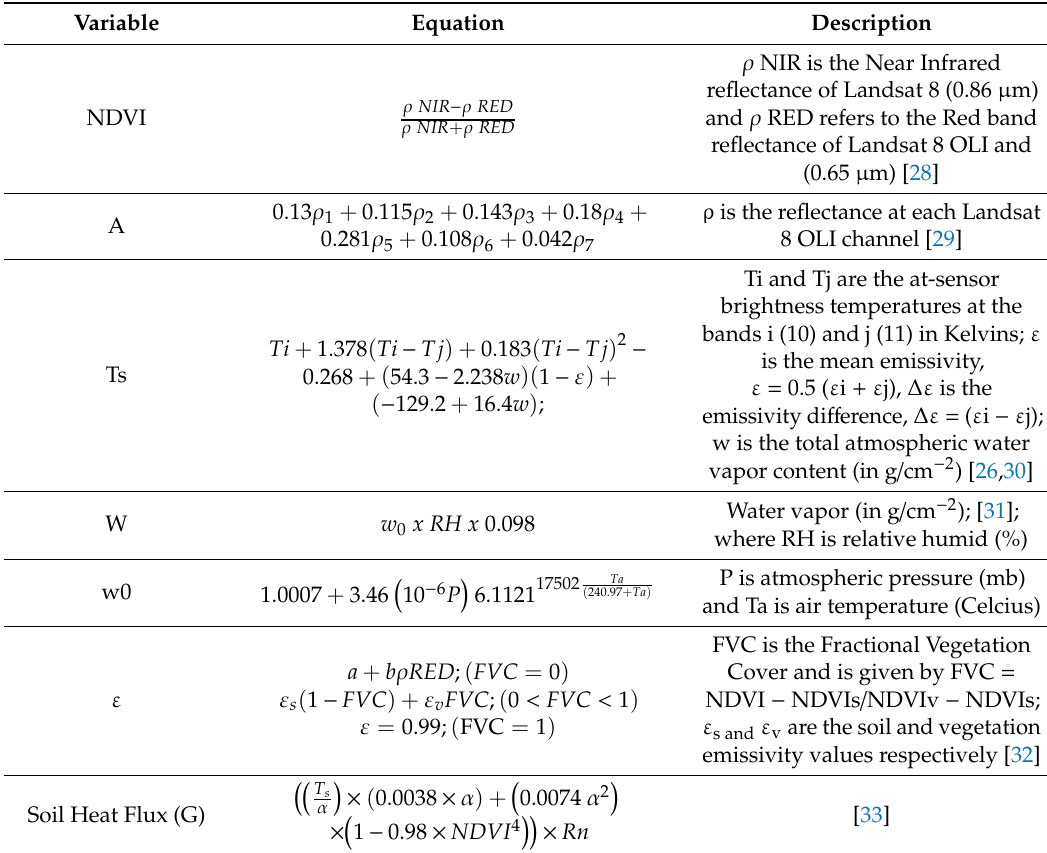
Table 3. Equations applied to Landsat-8